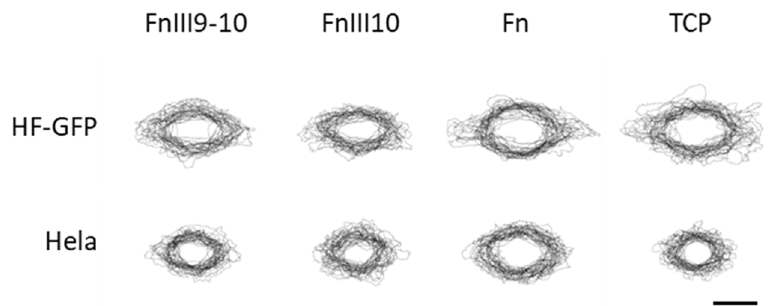
Figure 4. Cell shape analysis of GFP-transfected human fibroblasts (HF-GFP) and HeLa cells on FnIII9-10, FnIII10 and Fn -modified biochip surfaces and on tissue culture plate (TCP). The images show 30 randomly selected single-cell contours that were centered and aligned on the cell axis horizontally prior to the overlay. The scale bar is 50 µm.